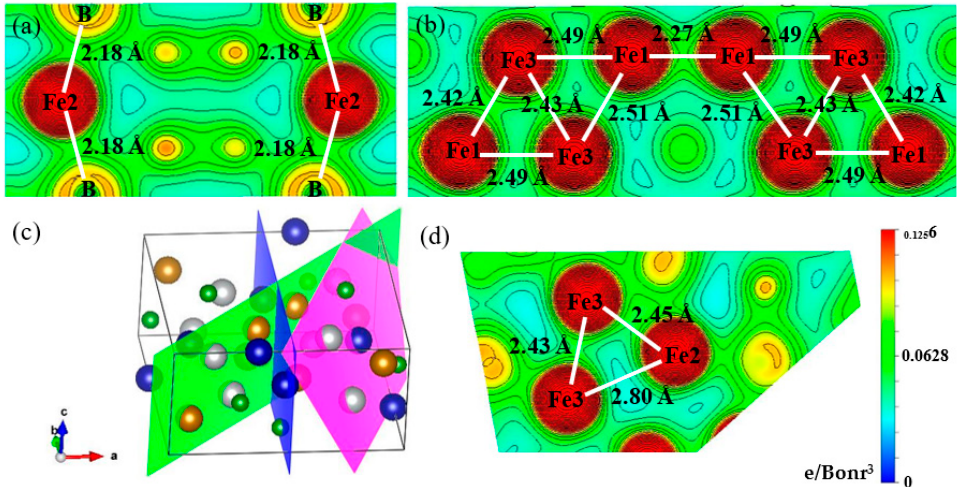
Figure 6. ( a ) Fe-B bonds with bond lengths of 2.18 Å; ( b ) Fe-Fe bonds with bond lengths of 2.27 Å, 2.42 Å, 2.43 Å, 2.51 Å and 2.49 Å; ( c ) crystal structure of Fe 3 B and ( d ) Fe-Fe bonds with bond lengths of 2.43 Å, 2.45 Å and 2.80 Å.